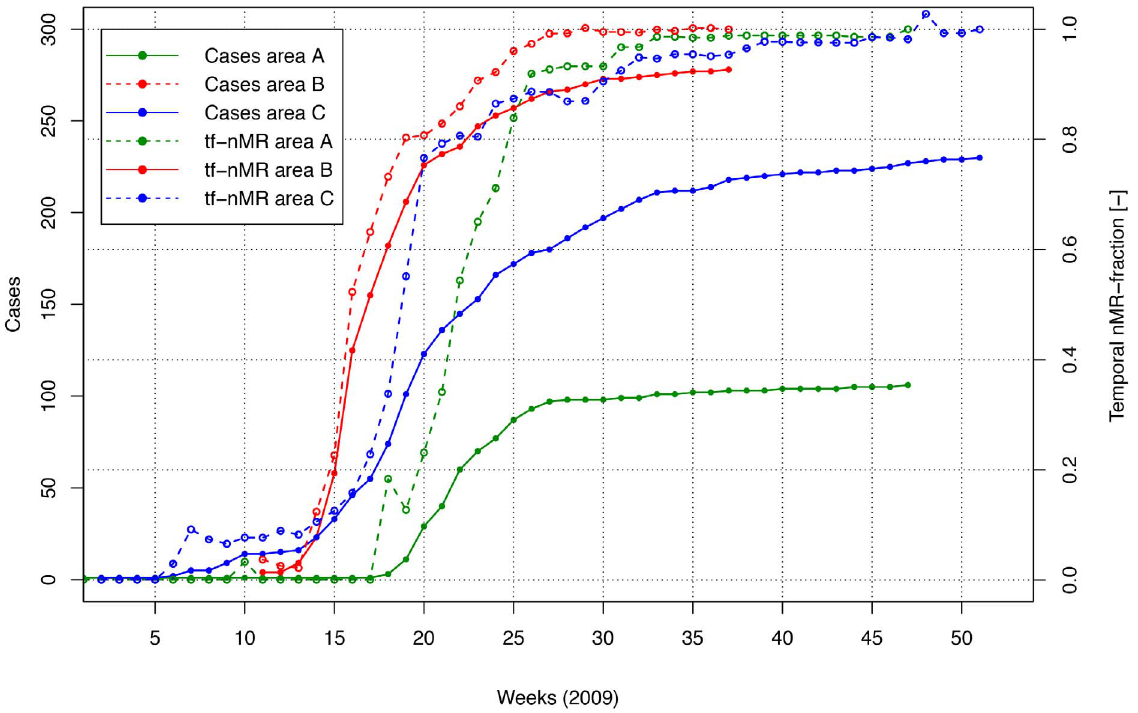
Figure 3. Cumulative number of cases per week (solid lines) and the temporal nMR-fraction (‘‘tf-nMR’’) (i.e. the spatial cumulative nMR-values per week as fraction of spatial cumulative nMR-values using all cases of 2009) (dashed lines) for the areas A (green), B (red), and C (blue). doi:10.1371/journal.pone.0080412.g003 PLOS ONE |